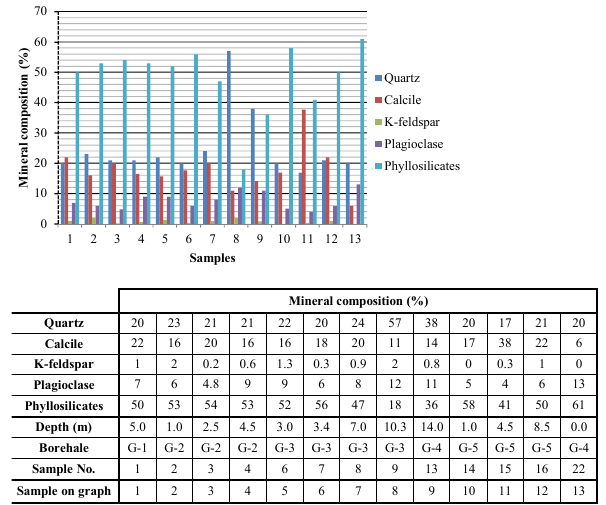
Figure 4. The mineralogical composition of the material samples from Grohovo landslide (Benac et al., 2014, modified by Elvis Žic).